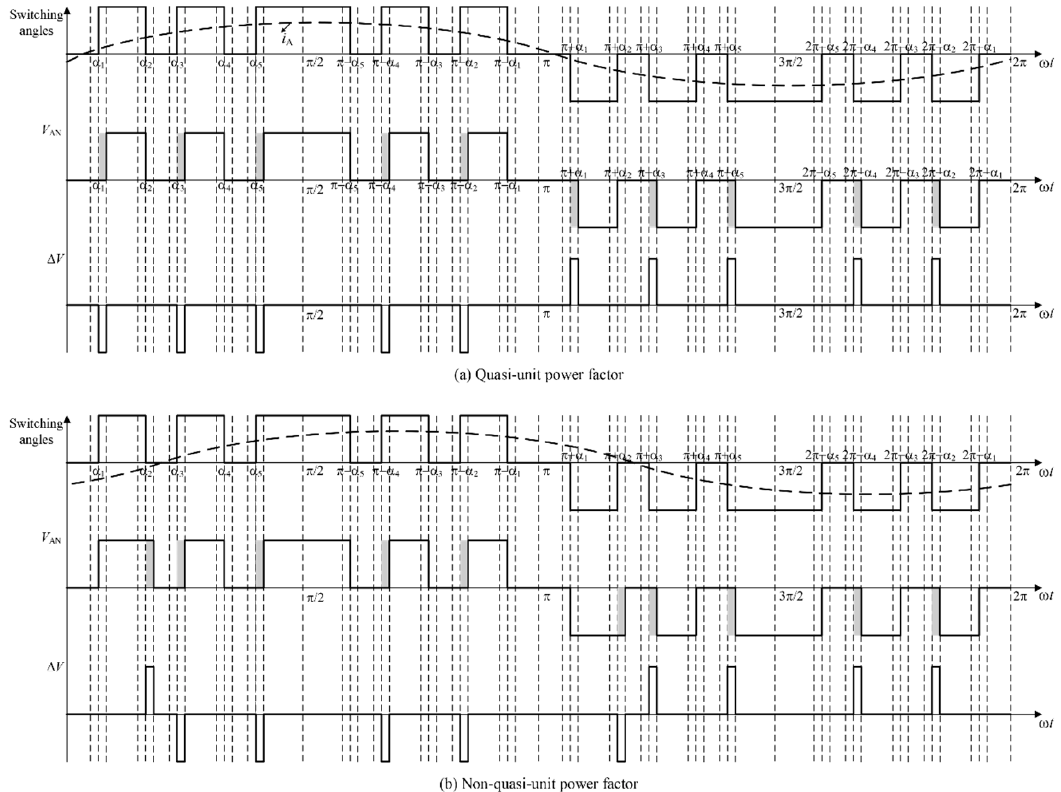
Figure 7. Output voltage error caused by dead time at quasi-unit power factor ( a ), and non-quasi-unit power factor ( b ).